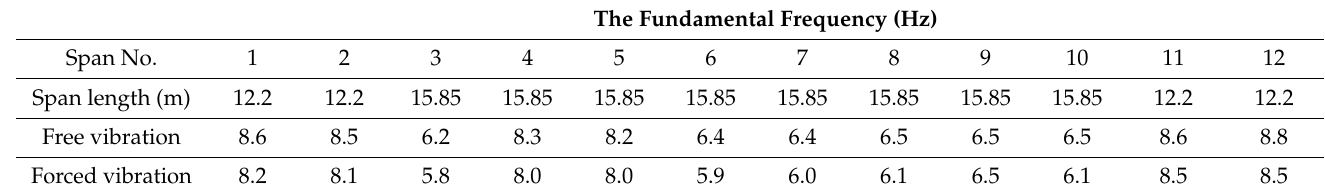
Table 1. The 1st Natural Frequencies of each span. The Fundamental Frequency (Hz)